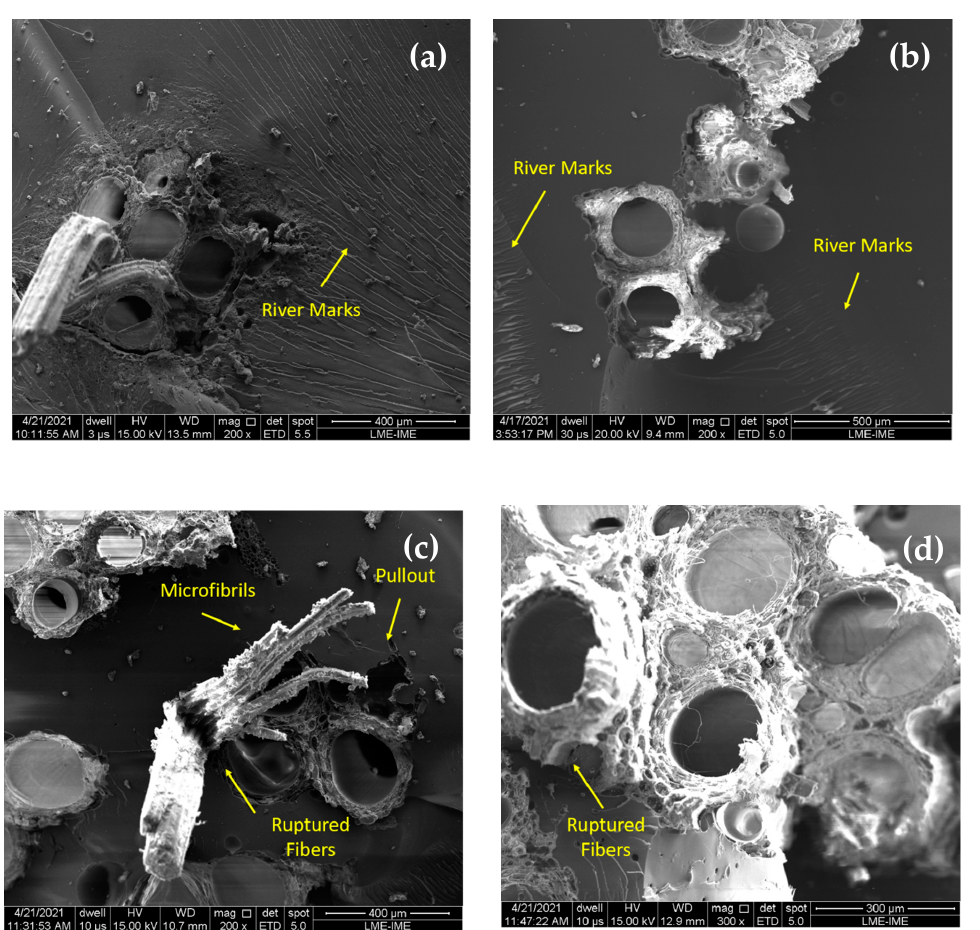
Figure 11. SEM of fracture surfaces of composites incorporated with untreated TVFs after Charpy impact tests: ( a ) 10 vol% TVF; ( b ) 20 vol% TVF; ( c ) 30 vol% TVF; and ( d ) 40 vol% TVF.